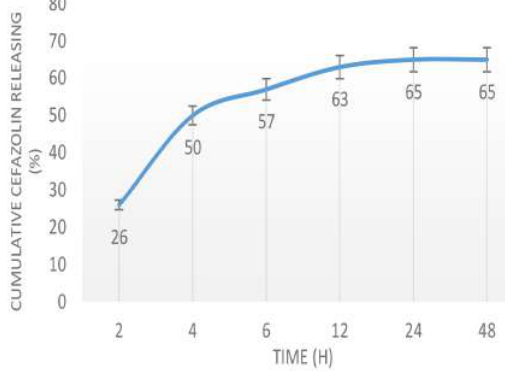
Fig. 4. Controlled release of cefazolin from electrospun nanofibers containing 1 wt% drug on time